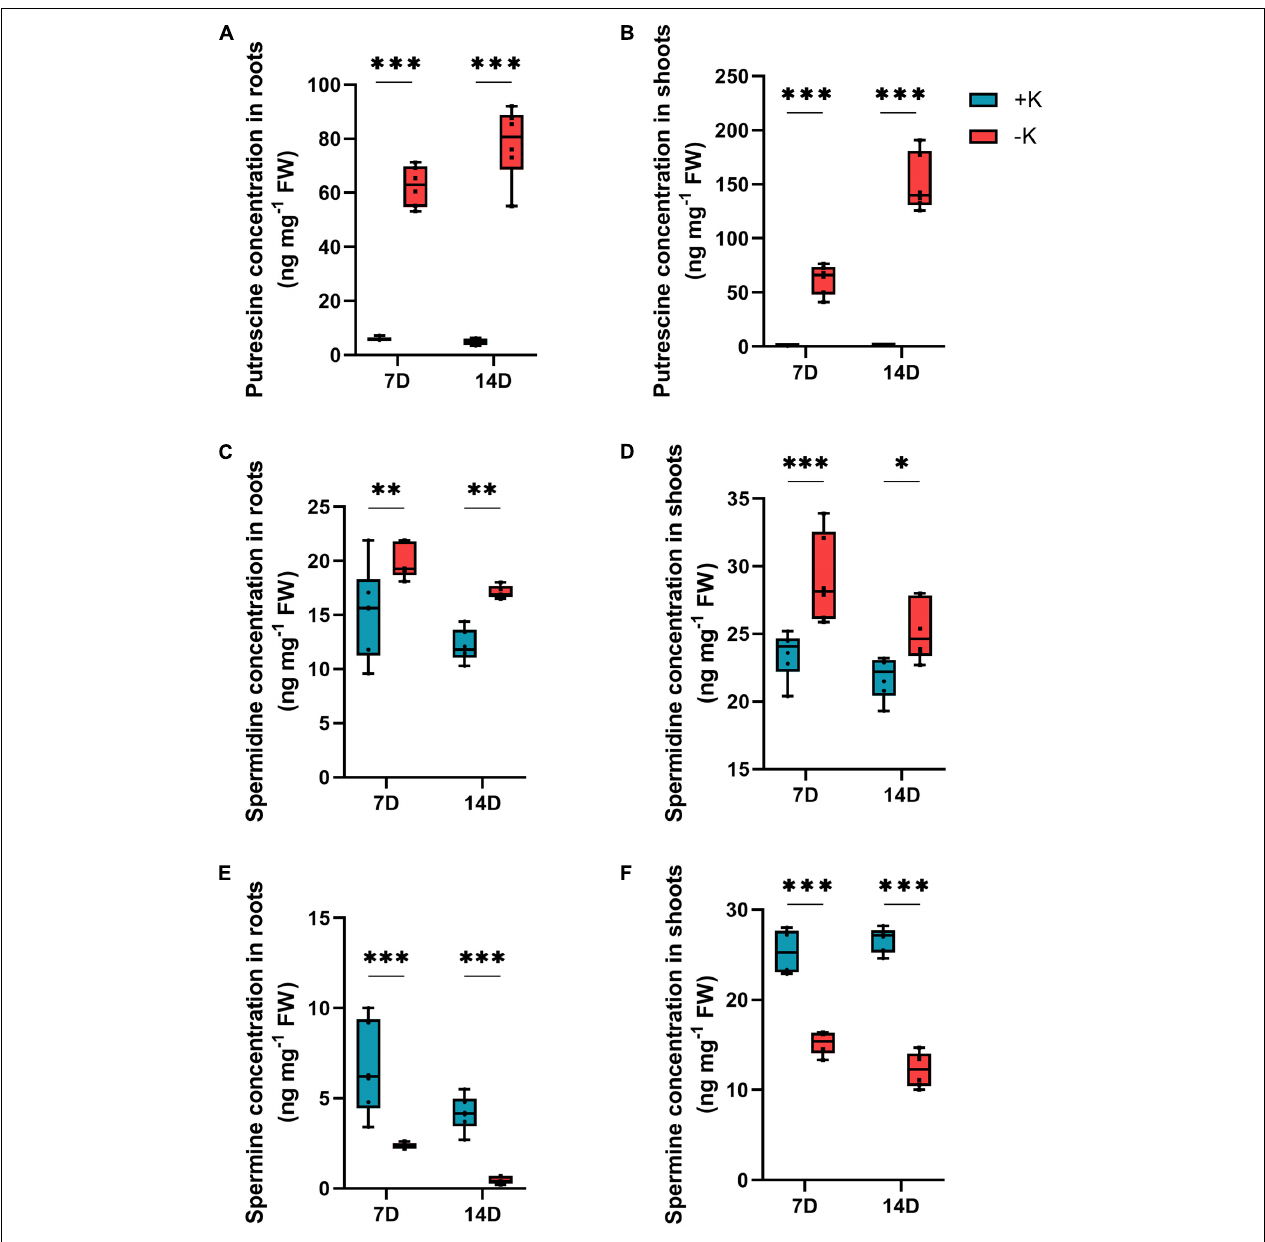
FIGURE 7 | Influence of K deficiency on the concentration of polyamines in rapeseed plants. (A) Putrescine (Put) concentration in roots; (B) Put concentration in shoots; (C) spermidine concentration in roots; (D) spermidine concentration in shoots; (E) spermine concentration in roots and (F) spermine concentration in shoots. Plants were grown in a hydroponic culture under either –K (0 mM) or + K (2 mM). The roots and shoots were harvested after 7 or 14 days of K deprivation. Asterisks denote the significant level of the difference according to t -test ( ∗ p < 0.05, ∗∗ p < 0.01, and ∗∗∗ p < 0.001, n =